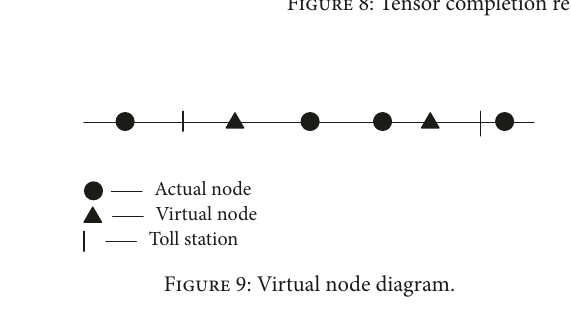
Figure 8: Tensor completion results (January 5, 2016). (a) Speed. (b) Volume.